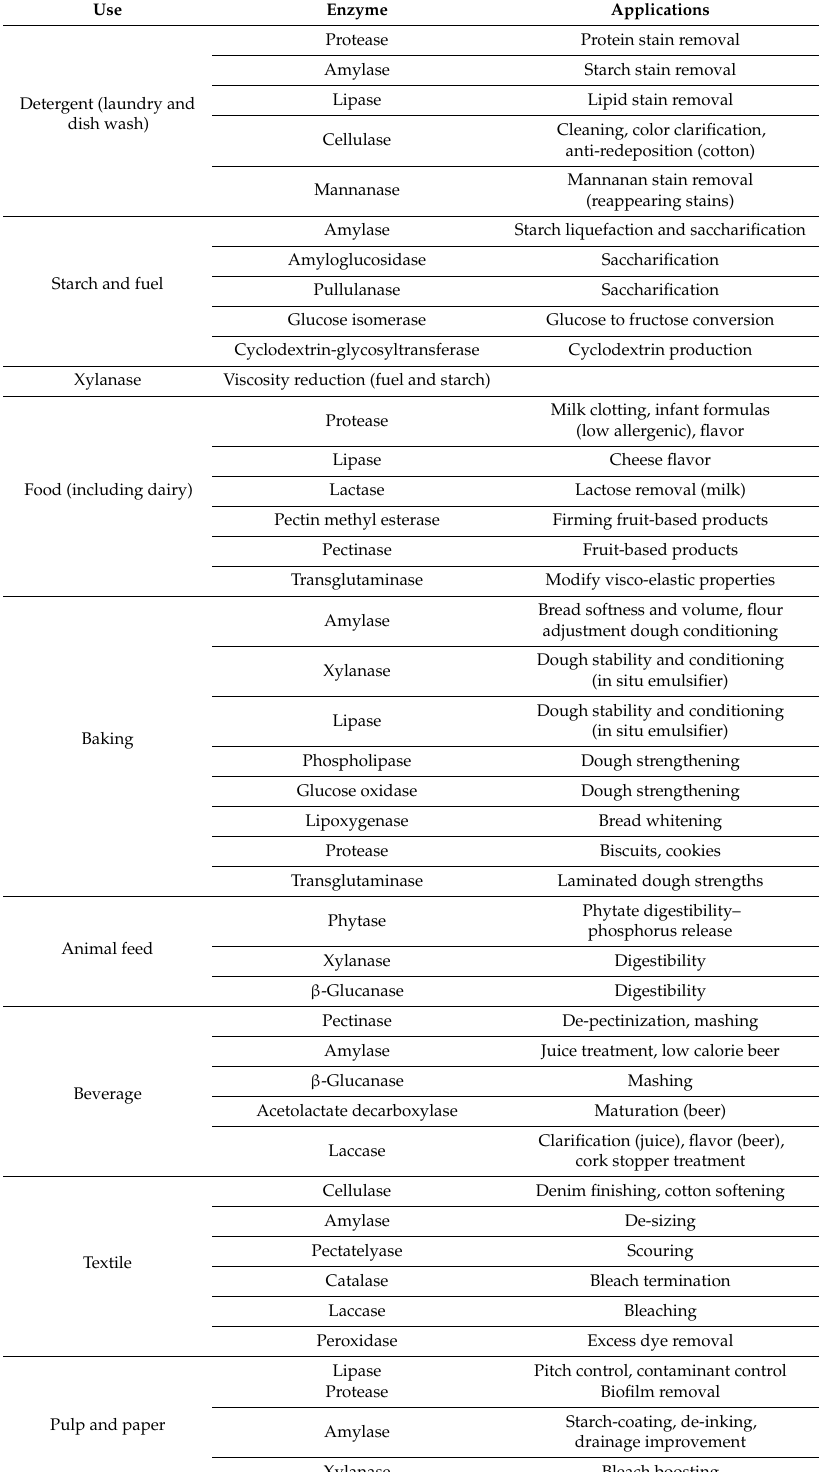
Table 3. Selected Actinobacteria and their biotechnological